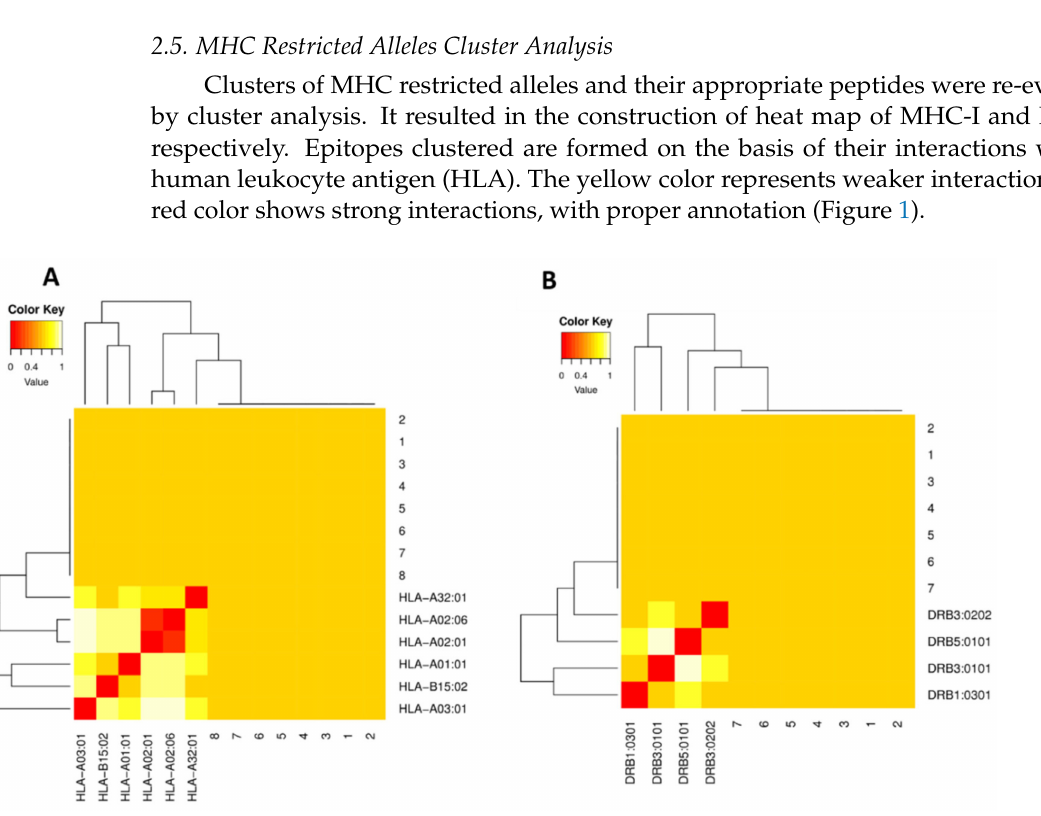
Figure 1. Clustering analysis for MHC class I and II epitopes. ( A ) The cluster analysis of MHC molecules and HLA alleles (MHC class I clustering alleles). ( B ) MHC class II clustering alleles. Red color indicates strong interaction while yellow zone indicates a weaker